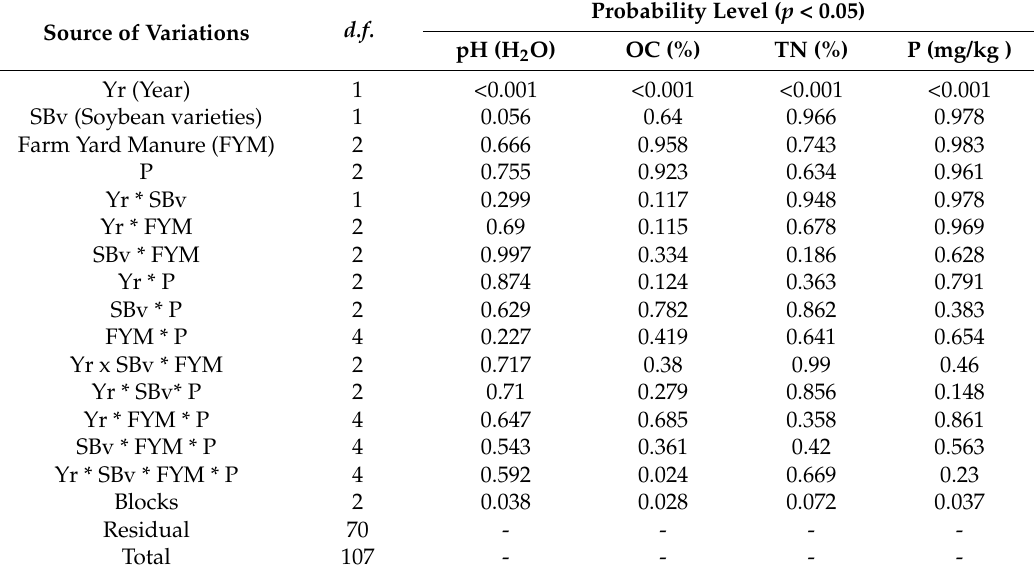
Table 3. Combined analysis of variances for pH, organic carbon, total nitrogen and extractable phosphorus after soybean harvest in the 2012 and 2014 cropping seasons at Bako, Western Ethiopia.